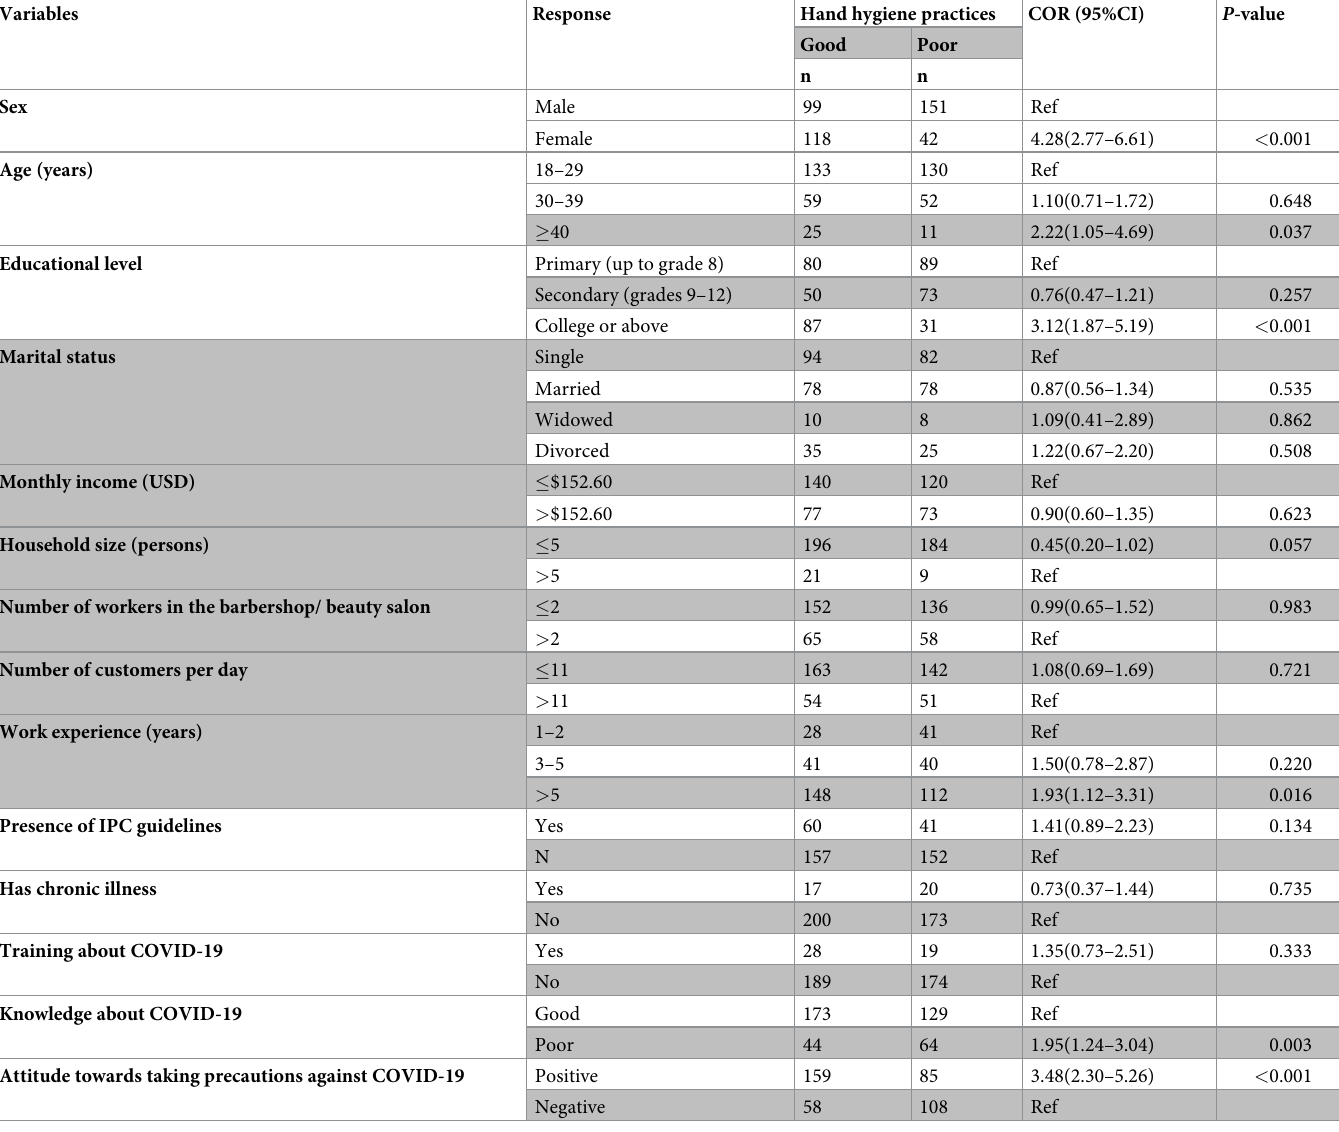
Table 5. Factors associated with good hand hygiene practices among barbers and beauty salon workers in bivariate logistic regression analysis in Dessie City and Kombolcha Town, Northeastern Ethiopia, January 5 to February 10,